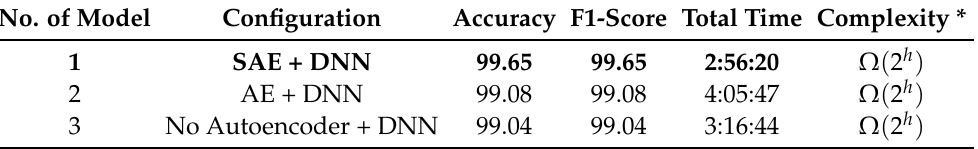
Table 11. Performance metrics for the cloneid _50 n node data set.